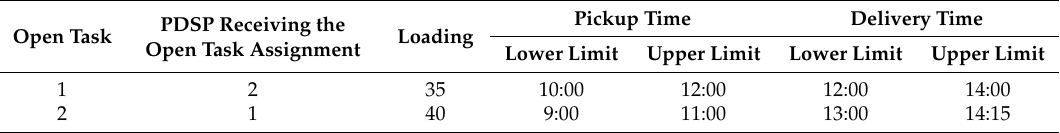
Table 4. Time frame parameters and package volumes of open tasks of the scenarios. Open